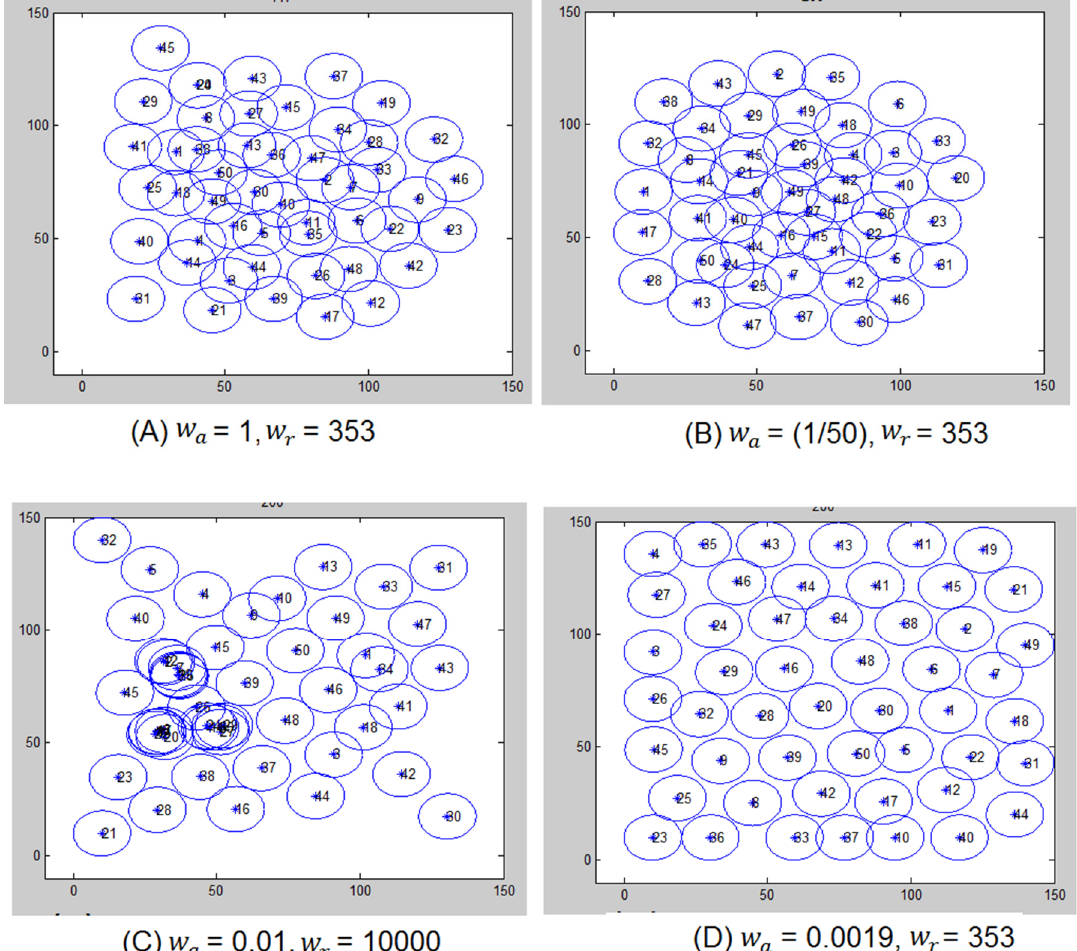
Figure 1. Effect of different setting of (cid:1875) (cid:3028) , N =50.